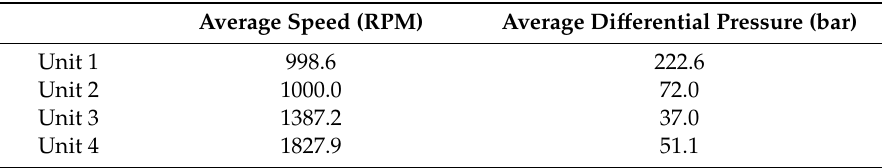
Table 4. System response to static operating conditions.